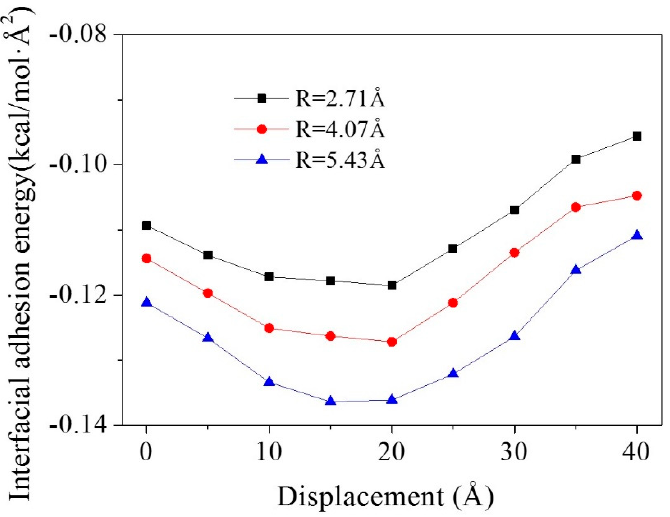
Figure 6. Interfacial adhesion energies for composite models with different CNT radii during the pullout